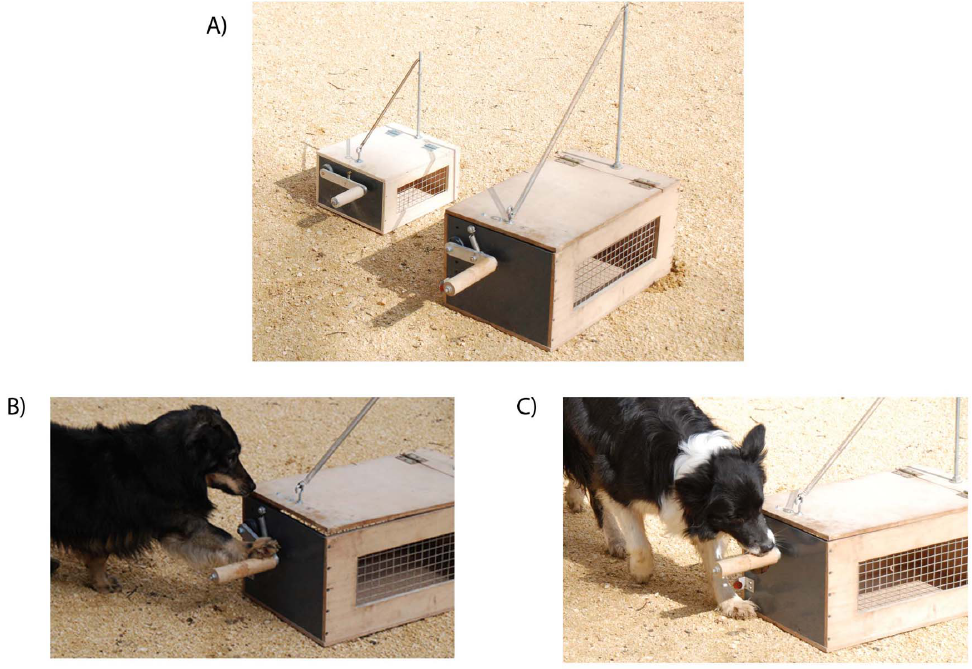
Figure 1. Pictures of the test apparatus and the two kinds of demonstrations. A) the two different sizes of the experimental apparatuses; B) a paw demonstration; C) a mouth demonstration.